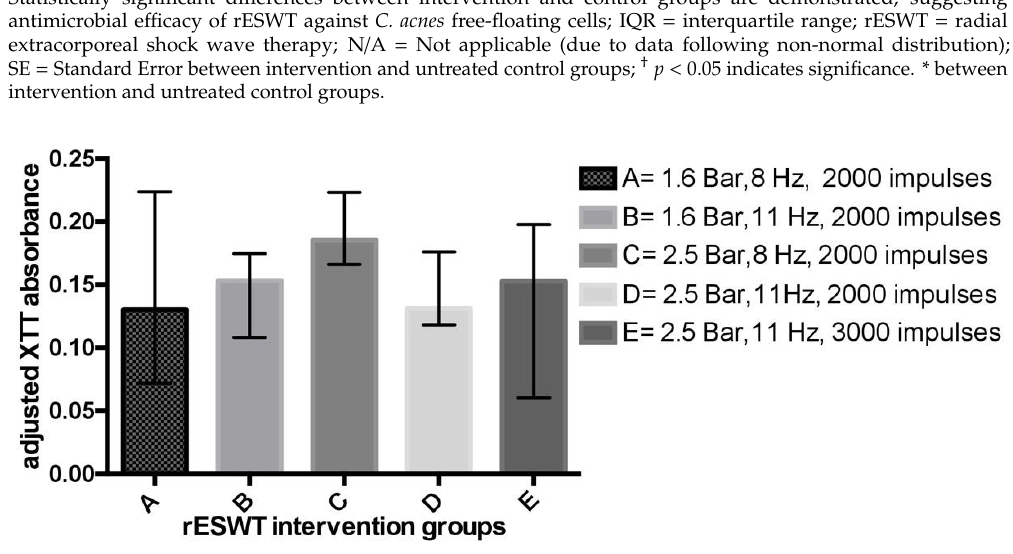
Figure 2. Antimicrobial effects of radial shock waves against C. acnes planktonic form expressed as adjusted median absorbances. rESWT = radial extracorporeal shock wave therapy; XTT = 2,3-bis(2- Table 2. Antibiofilm activity of rESWT on C. acnes